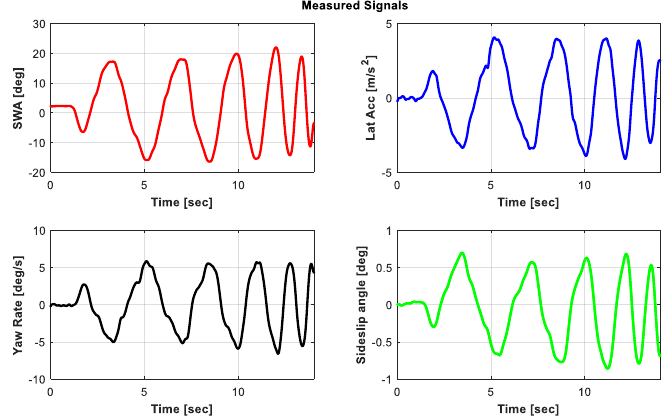
Figure 2. Experimental test measurements: sine-sweep test.